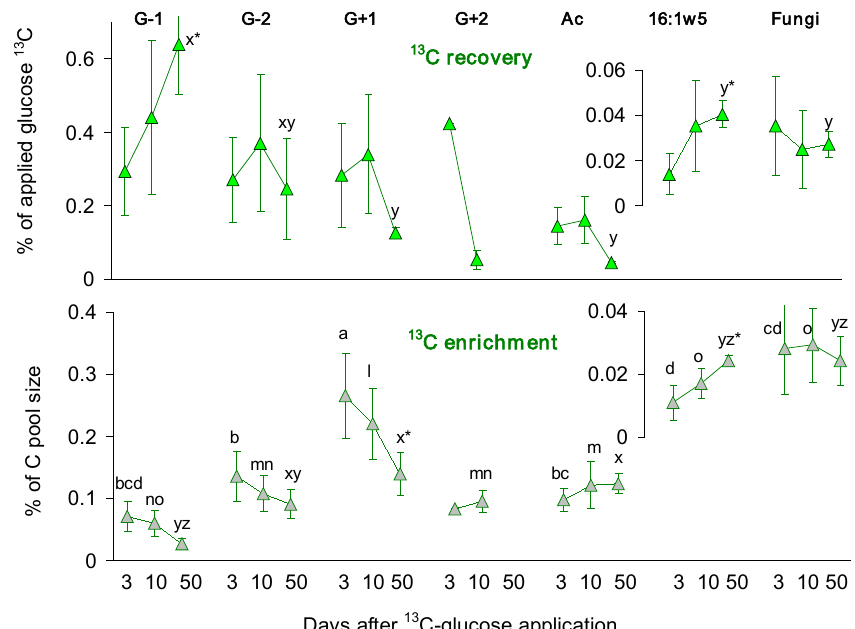
Figure 3. Recovery of glucose-derived 13 C (top) and 13 C enrichment (bottom) of the microbial PLFAs. Note that the values for 16 : 1 ω 5 and fungi are scaled up 10 times (secondary y axis) compared to those of other groups ( y axis on the left). Data present the mean ( n = 4) and bars present standard errors. Small letters reflect differences between the microbial groups for 13 C recovery and 13 C enrichment from glucose; letters (a–d) are for day 3, (l–o) are for day 10, and (x–z) are for day